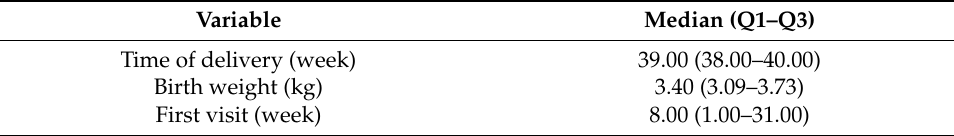
Table 1. Demographic data of patients.